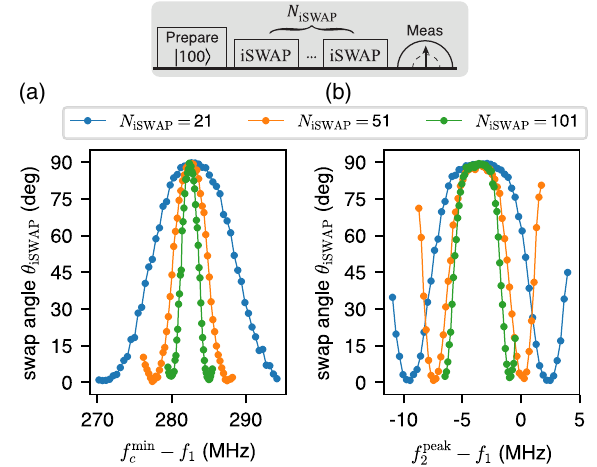
for iSWAP for multiple iSWAP